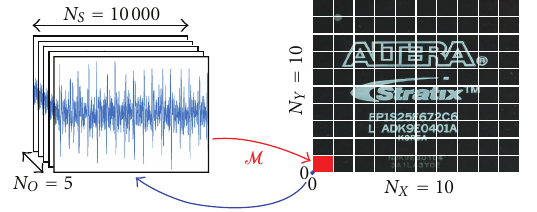
Figure 1: Cartography principle commonly